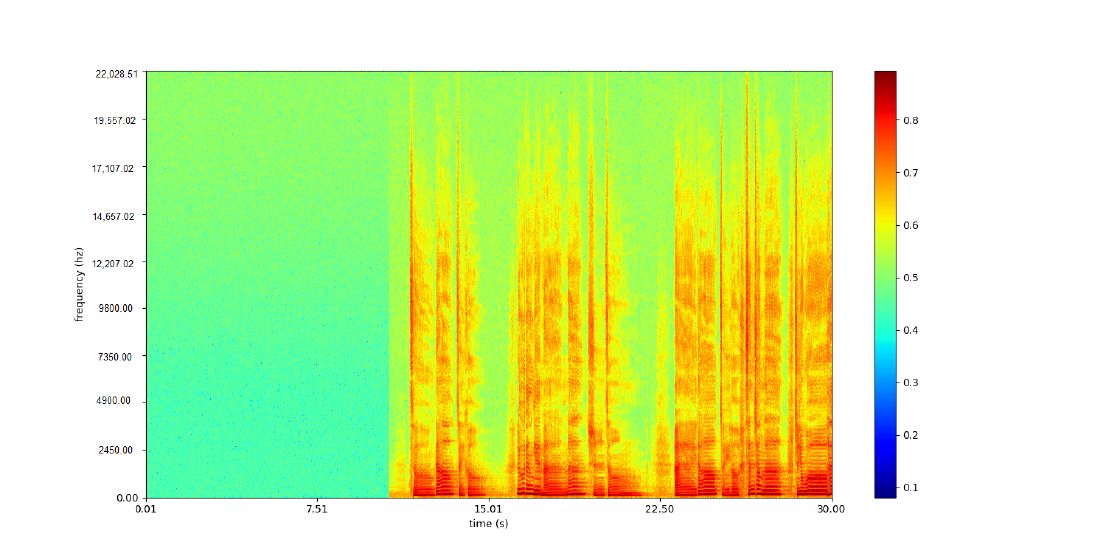
Figure 12. The spectrum of the accompaniment of a song from